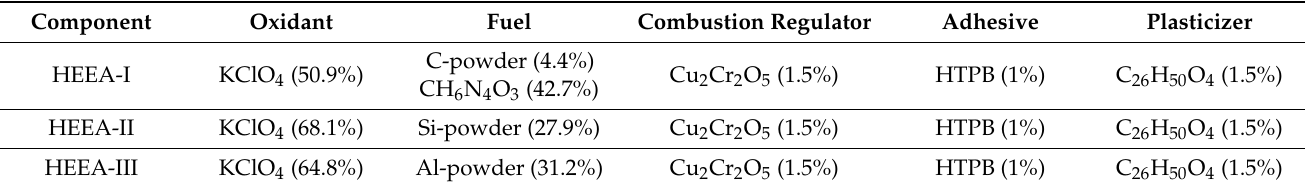
Table 1. Mass ratio of high-energy expansion agent admixture components. Component Oxidant Fuel Adhesive